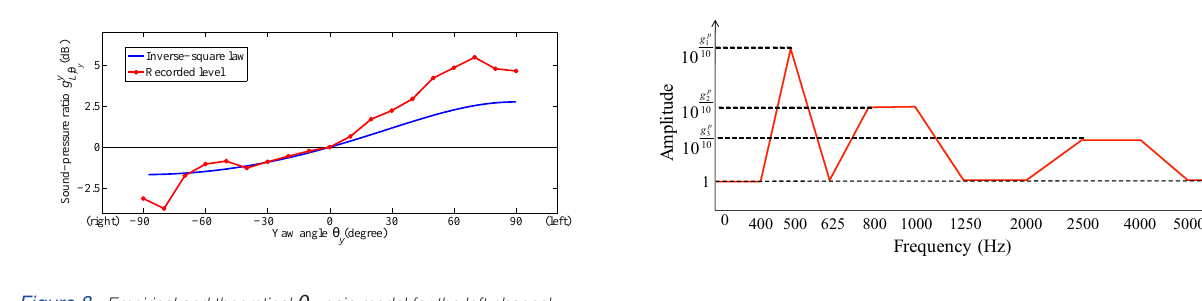
Figure 9. The amplitude of spectral envelope for pitch axis H p ( w ; q p ( t ))